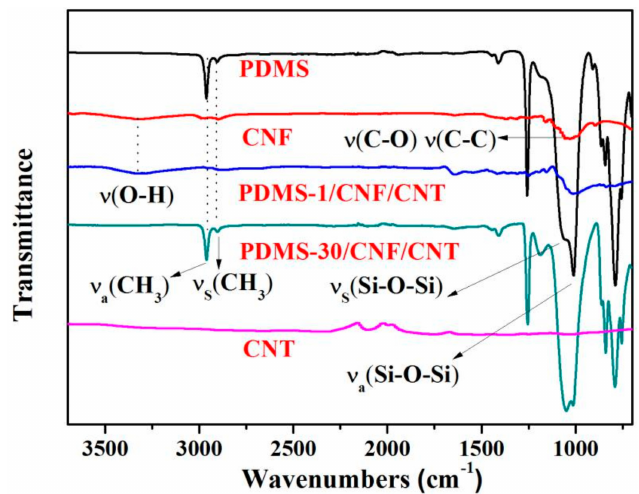
Figure 5. FTIR spectra of PDMS, CNF, CNT, and PDMS/CNF/CNT nanocomposite